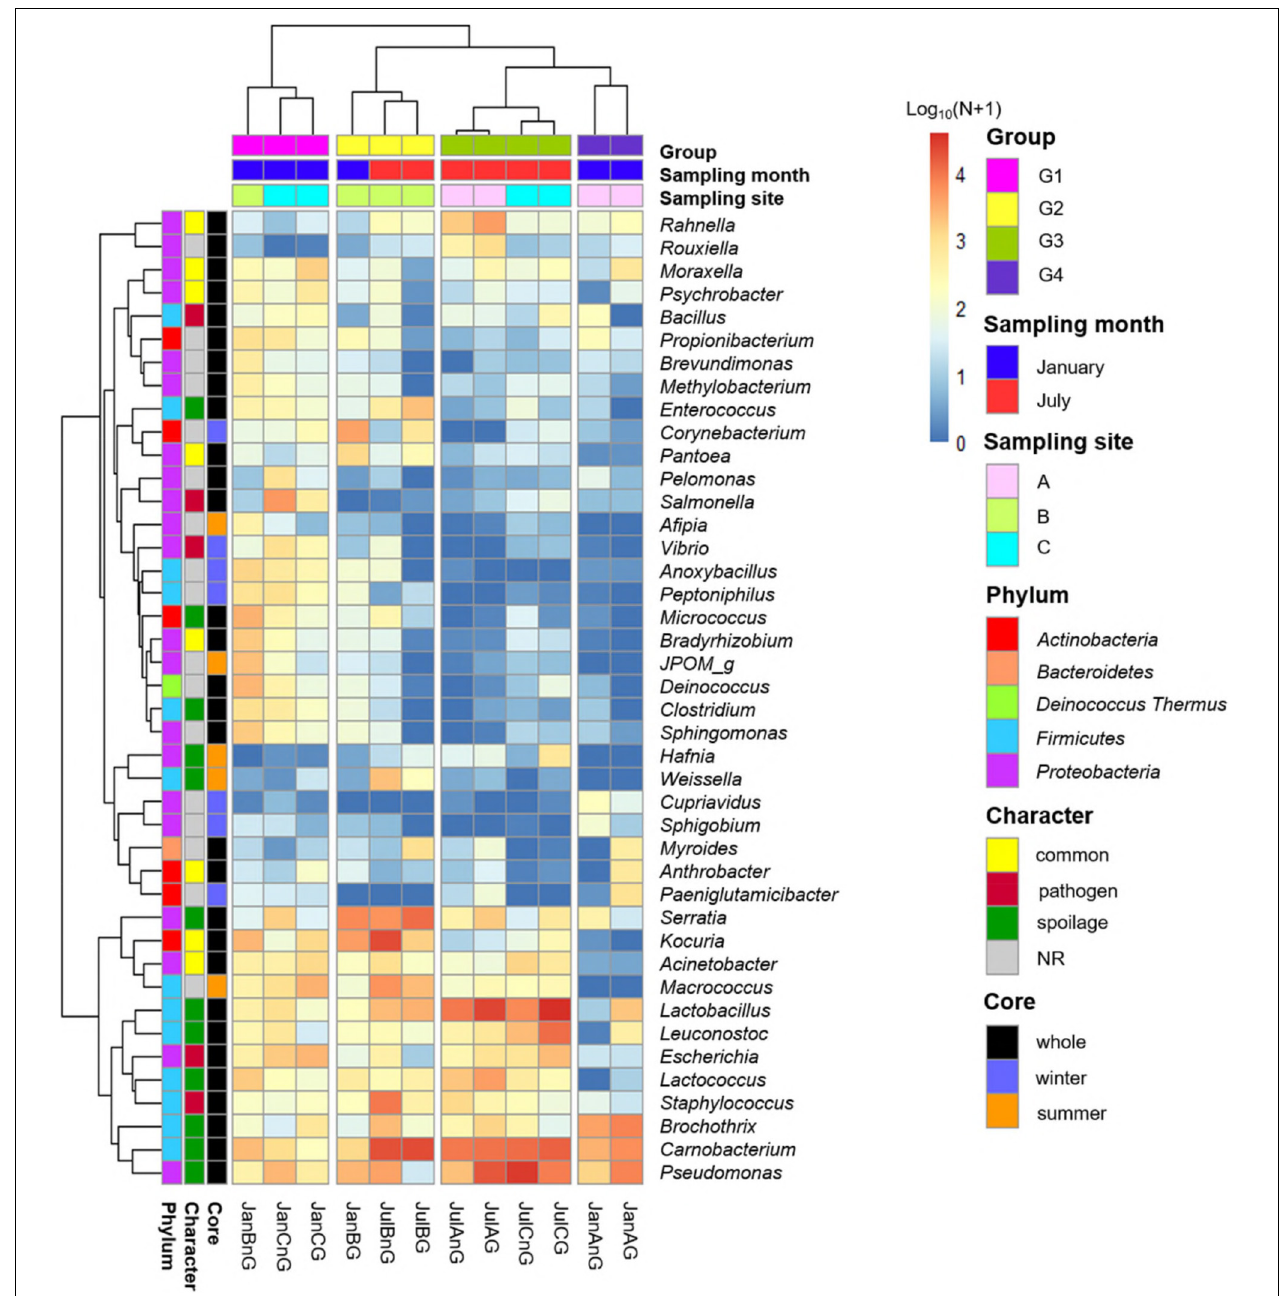
FIGURE 4 | Comparison of core genera using heat map analysis. The relative abundances of genera were calculated by a log10 scale. Samples were clustered to groups 1, 2, 3, and 4 by spearman correlations. Core genera were characterized by common, pathogen, spoilage, and NR.